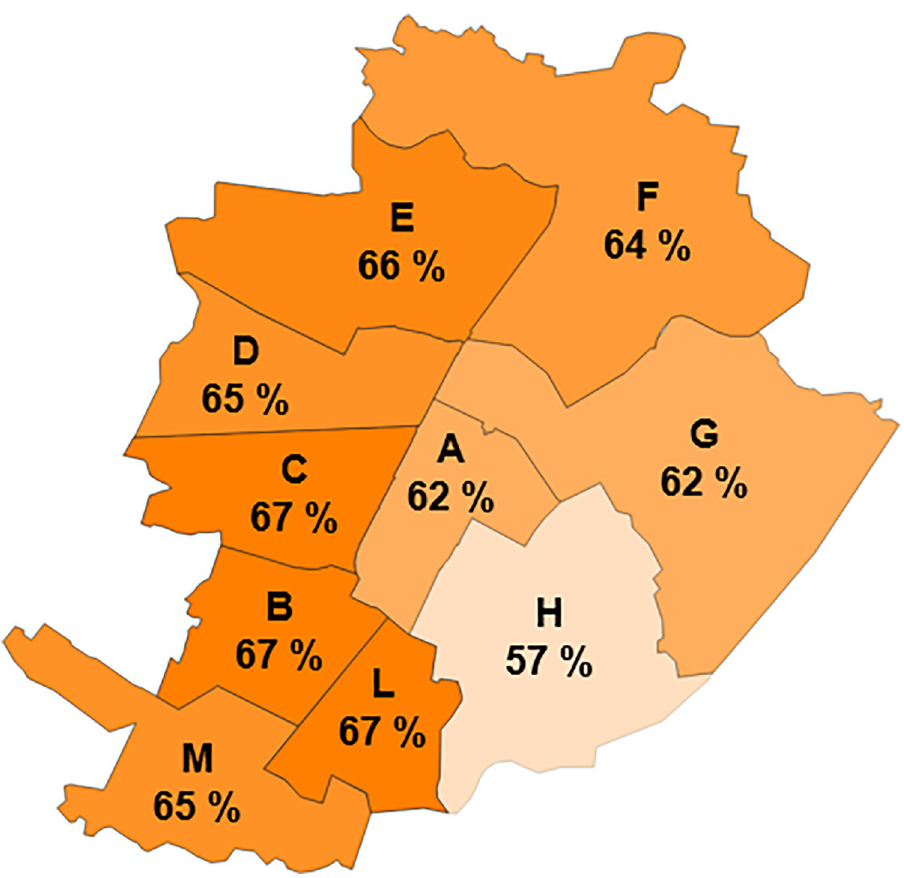
Fig 6. Domestic use of rainwater. The retention efficiency of each